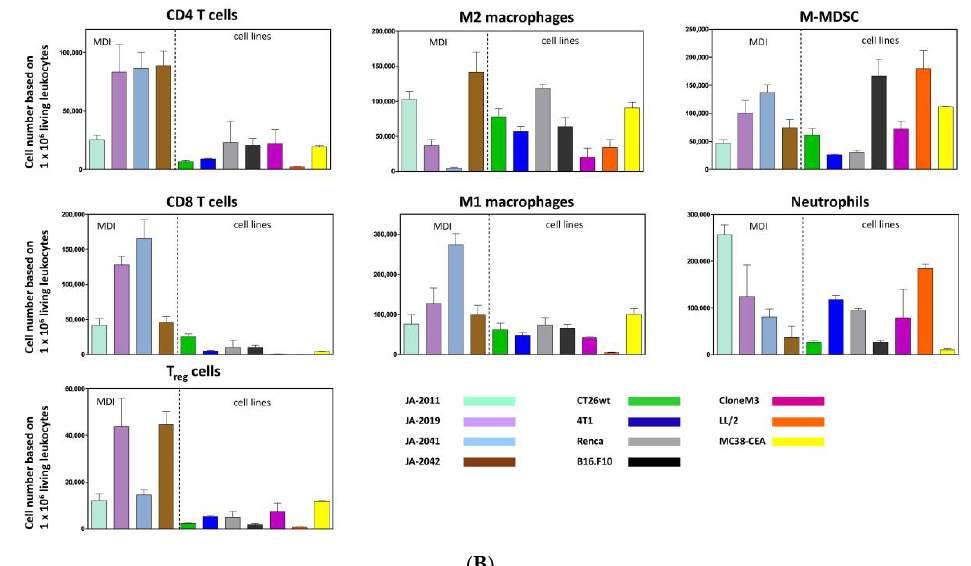
Figure 4. ( A ). Flow cytometric analysis of cMDI tumor-infiltrating leukocytes. Representative flow cytometry plots of tumor-infiltrating CD4 + and CD8 + T-cells, T reg cells, M-MDSCs, neutrophils/G-MDSC (cells of CD11b + , Ly6G + , Ly6C int phenotype), and M1/M2 macrophage populations isolated from untreated syngeneic cMDI tumors JA-2011, JA-2019, JA-2041, and JA-2042. M-MDSC = monocytic myeloid-derived suppressor cells, MMR = macrophage mannose receptor, Treg = regulatory T-cells. ( B ). Quantitative flow cytometric analysis of cMDI tumor-infiltrating leukocytes. Flow cytometry analysis of tumor-infiltrating immune cells (quantitative analysis) in untreated syngeneic cMDI sarcoma JA-2011, JA-2019, JA-2041, and JA-2042 models and seven established